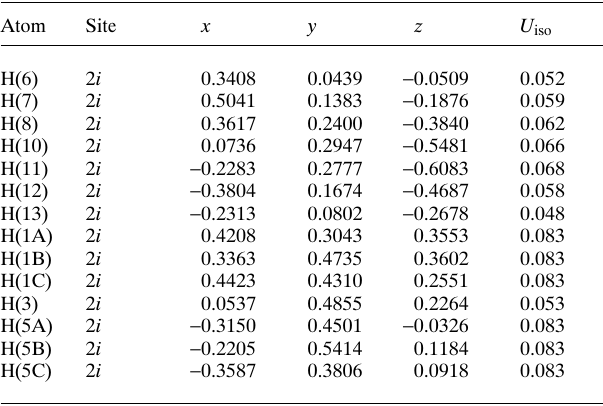
Table 2. Atomic coordinates and displacement parameters (in Å 2 )